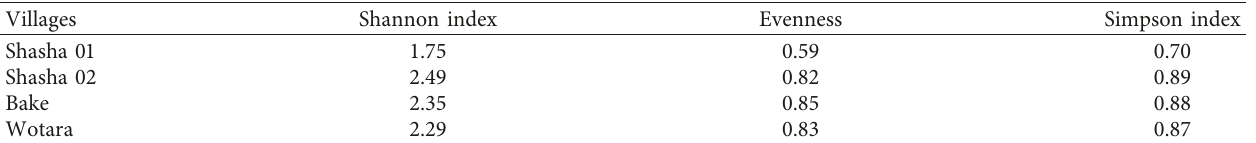
Table 3: Shannon index, Evenness, and Simpson diversity index of woody species.